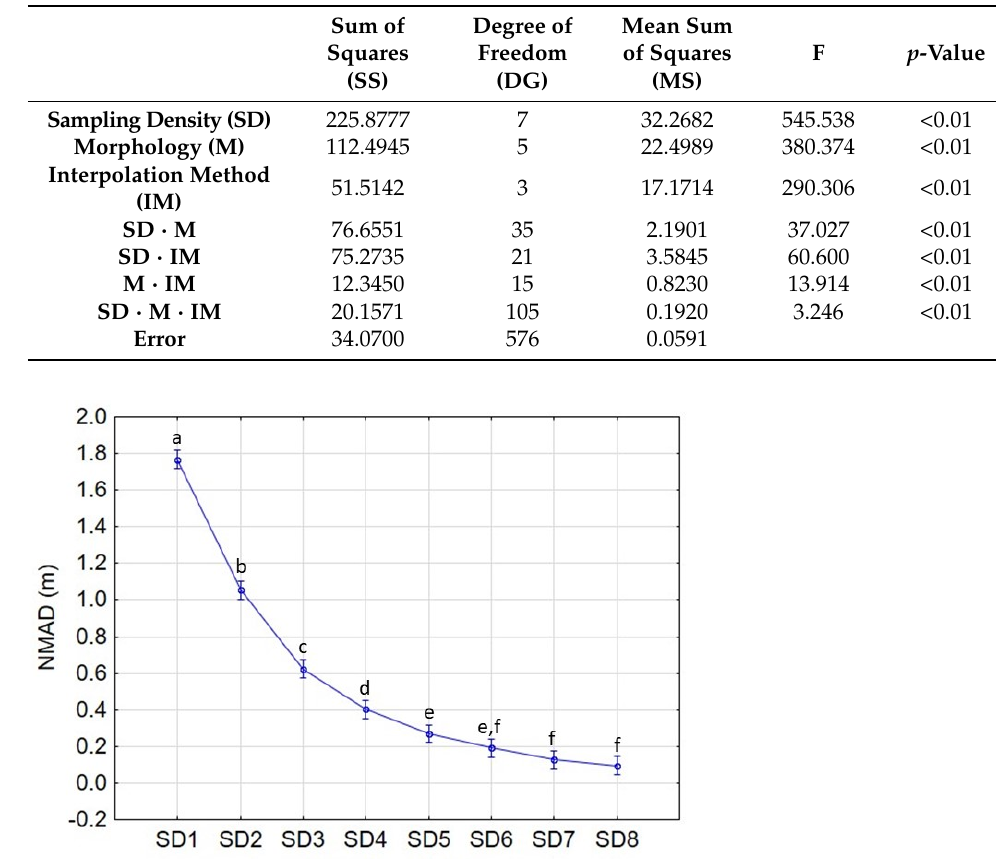
Table 4. ANOVA test results for vertical random error estimated from NMAD.